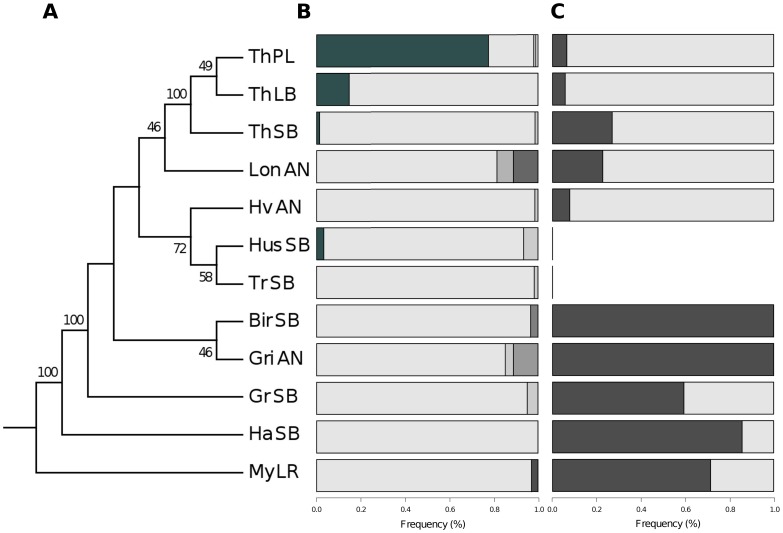
Arctic charr population history and variation in Cath2 and MHCIIα.A) A genealogy of the sampled populations was built from 9 microsatellite markers and the confidence intervals were estimated by 1000 bootstrap replicates [63]. B) Frequencies of the MHCIIα intron haplotypes (hap 14 is dark, hap15 light gray, rare haplotypes are in intermediate shades of gray). C) The frequency of Cath2 g819A (dark). Due to limited DNA available, the marker could not be typed in Husafell and Trussa. The same individuals where genotyped for all markers.